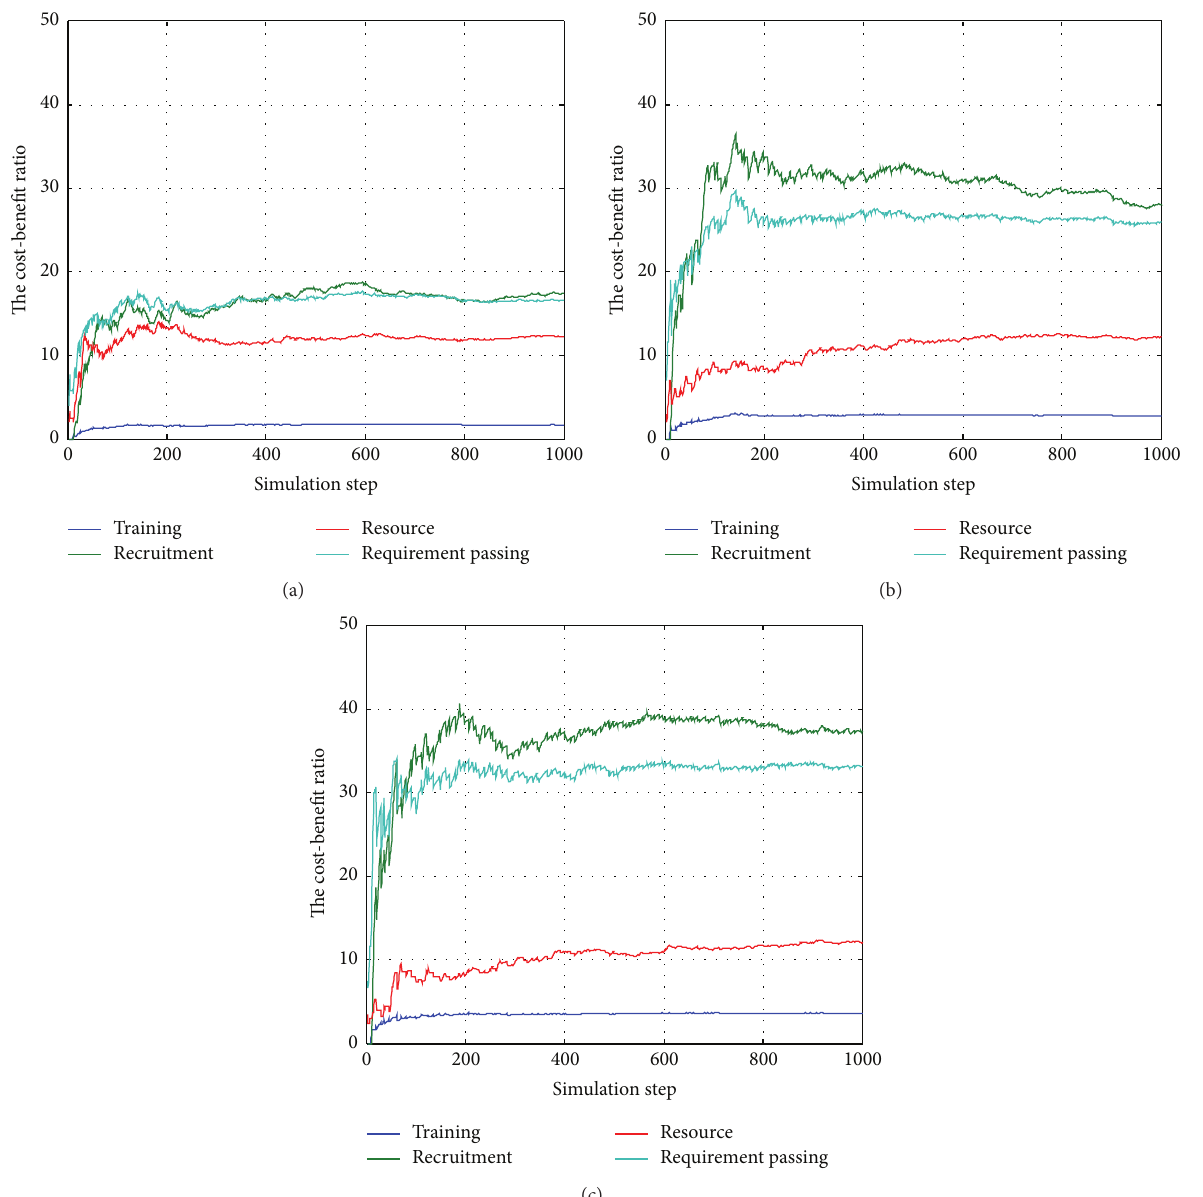
Figure 14: Simulation results of cost-benefit ratio under different arrest probability: (a) 0.3, (b) 0.5, and (c)